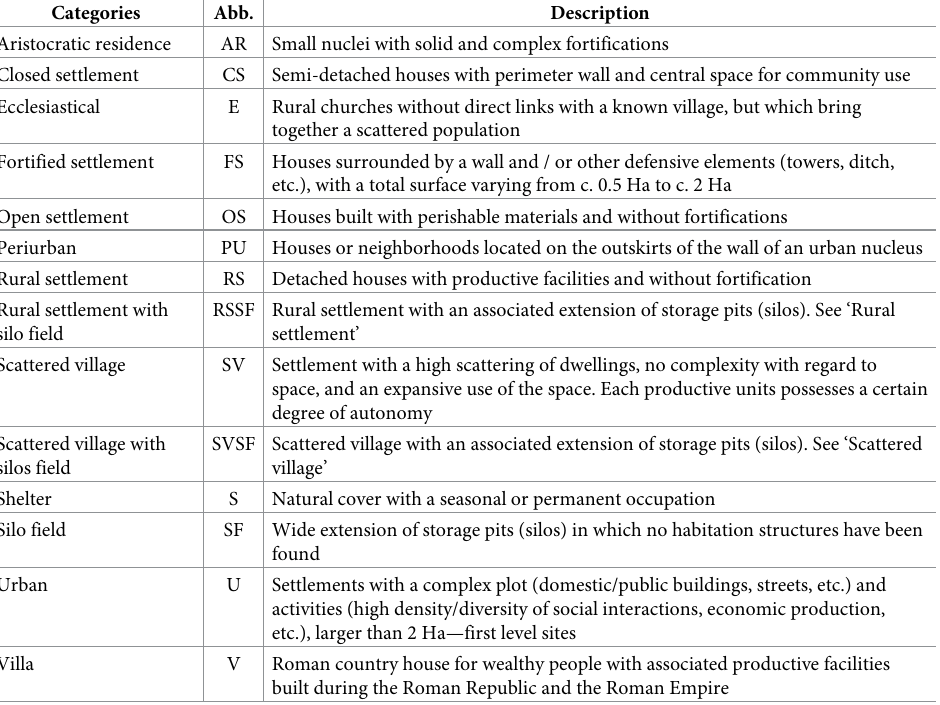
Table 2. Description of the types of site. For details see [27,28,59–62].